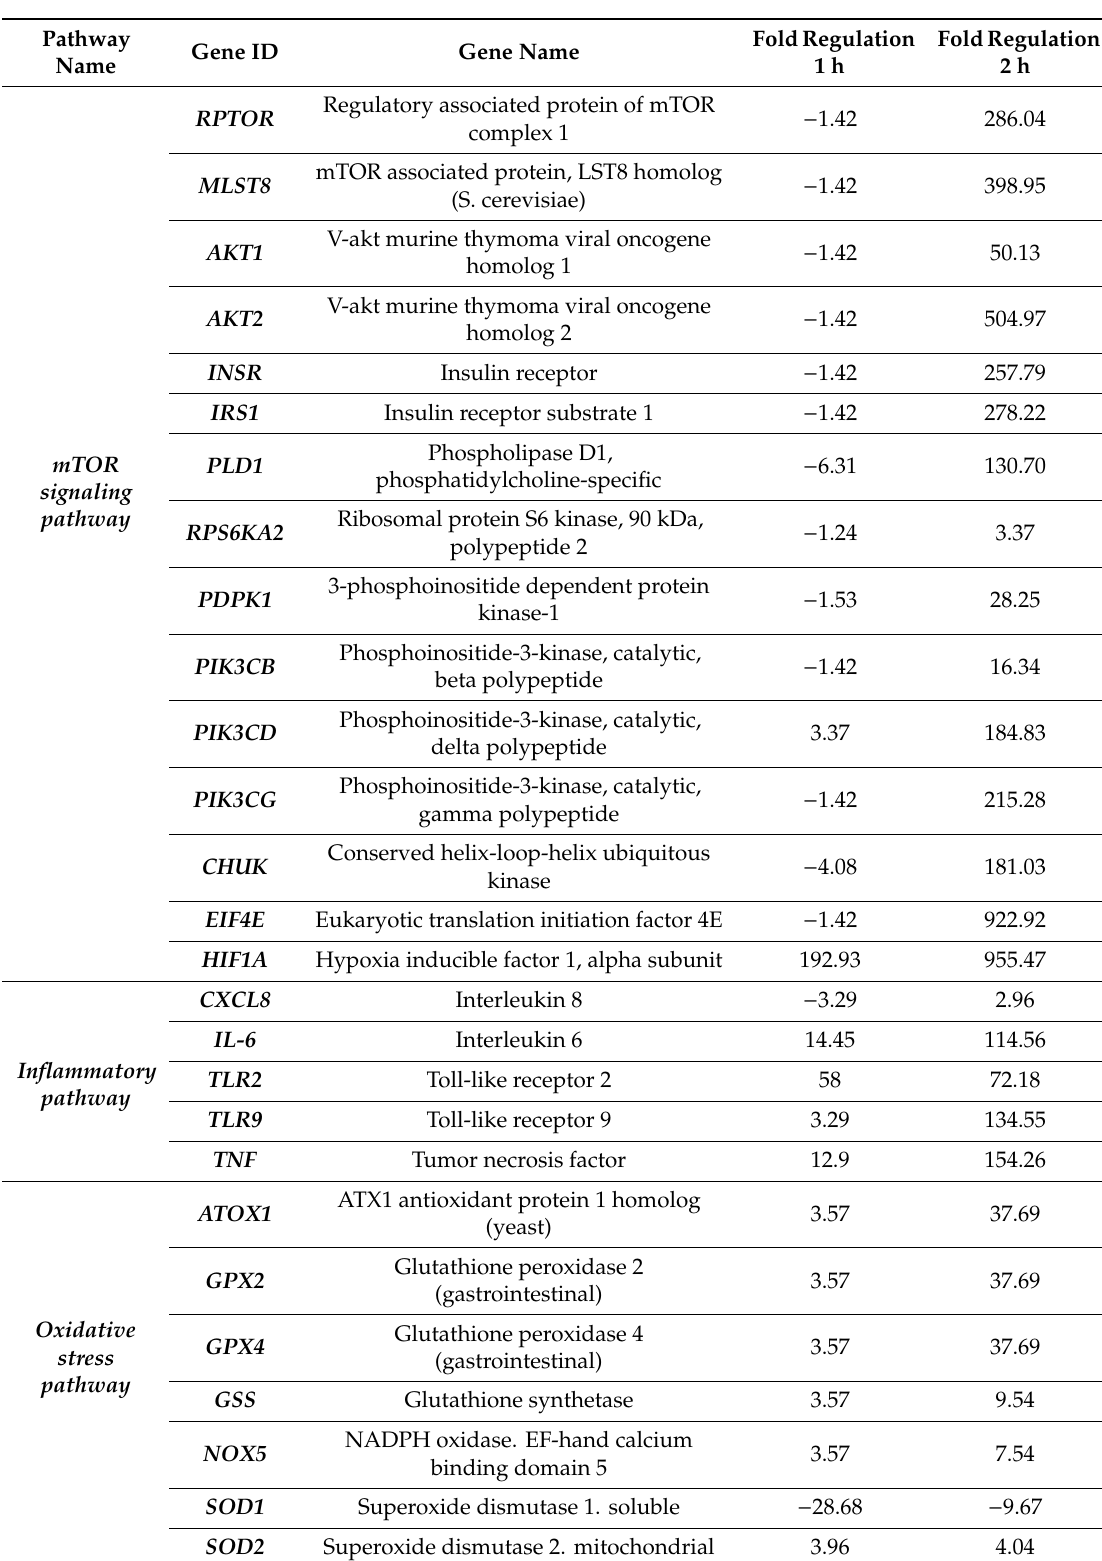
Table 1. Genes of mammalian Target Of Rapamycin ( mTOR ) signaling, inflammatory, and oxidative stress pathways detected by polymerase chain reaction (PCR) array technology and di ff erently expressed in MKN-28 cells incubated with Hpcf for 1 or 2 h. Variation of gene expression levels is reported as fold regulation. Values > | 2 | are considered statistically